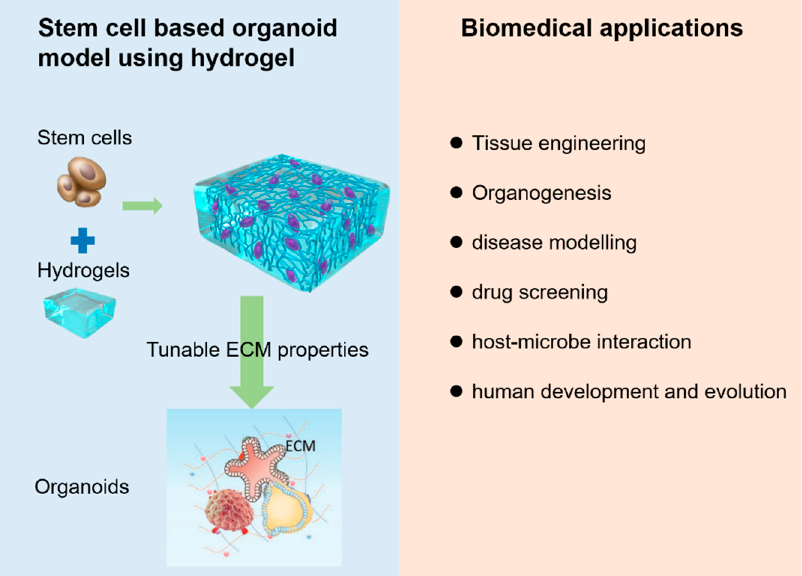
Figure 6. Schematic diagram of constructing stem-cell-derived organoids using hydrogel and their basic biomedical applications.